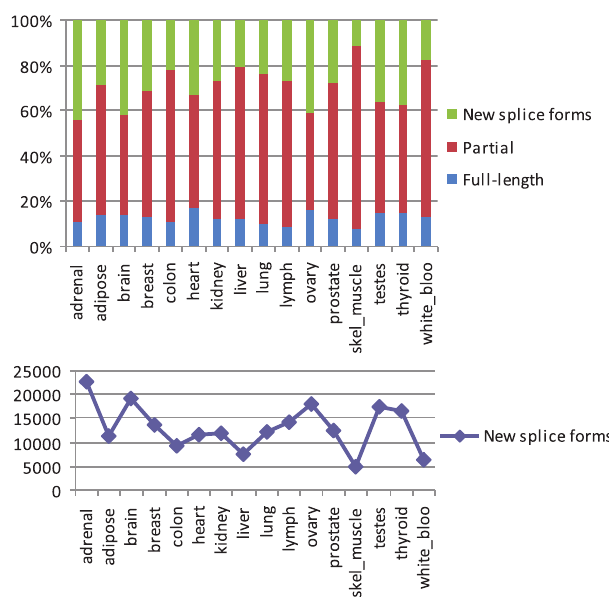
White_blood 5.5 *Genes containing multi-exon transcripts. † Averaged over multi-exon genes.